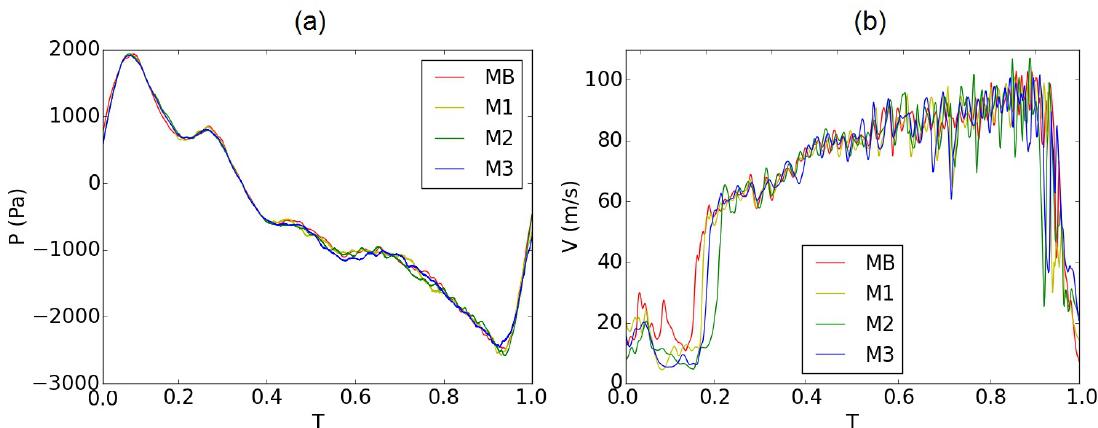
Figure 12. Instantaneous ( a ) pressure and ( b ) velocity evolutions for one cycle of oscillation at the point P1 introduced in Figure 1 for all the meshes. The pressure evolutions were smoothed by a low-pass filter (Savitzky-Golay filter [73] with a linear polynomial and a window size of 0.3 ms) to reduce numerical